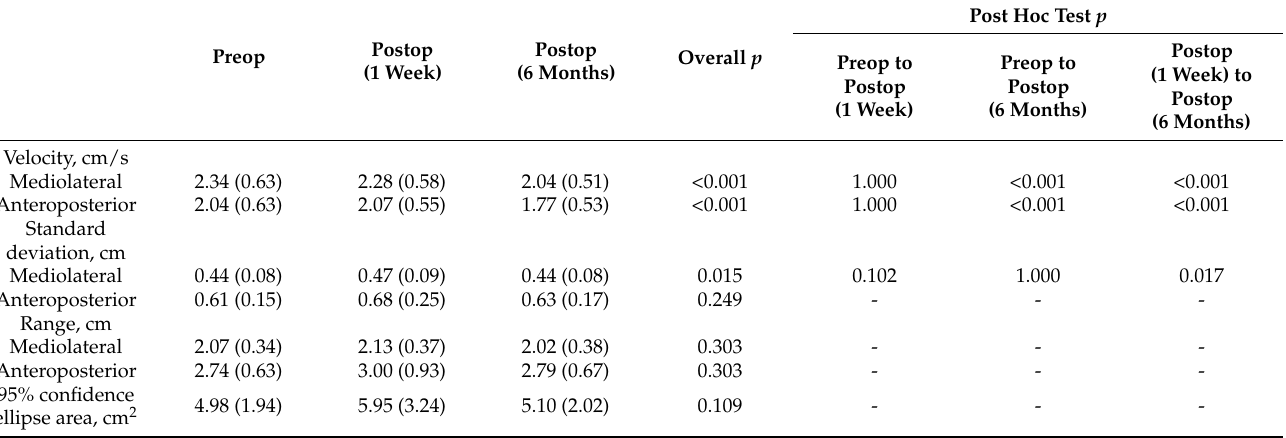
Figure 4. Mean and standard deviation values of the mean minimum of the time-to-boundary in medial, lateral, anterior, and posterior directions. Table 2. Mean and standard deviation value for the center of pressure parameters preoperatively and postoperatively.